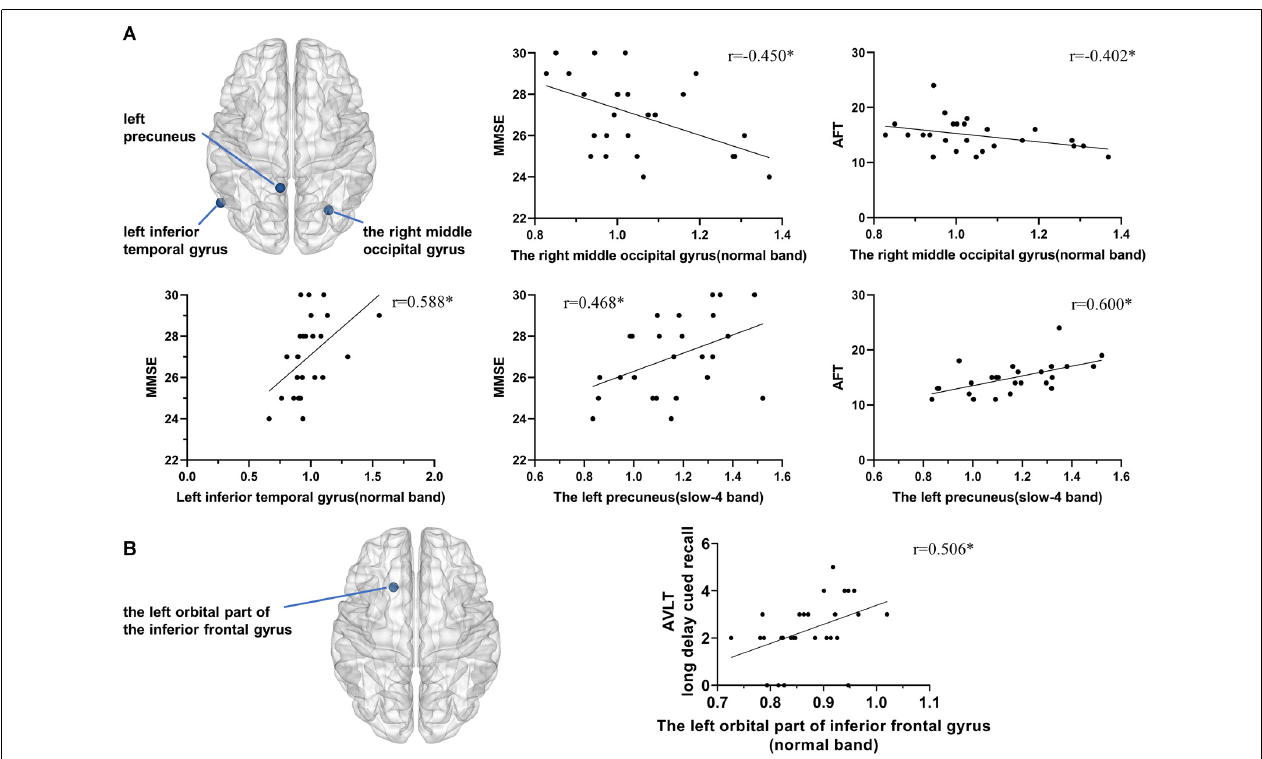
FIGURE 3 | Correlation between local functional activity and neuropsychological performance. (A) In the Obj-SCD group, in the normal band, the fALFF value of the right middle occipital gyrus was significantly negatively correlated with the MMSE score and AFT score; the left inferior temporal gyrus was significantly positively correlated with the MMSE score. In the slow-4 band, the fALFF value of the left precuneus was significantly positively correlated with the MMSE and AFT scores. (B) In the aMCI group, the fALFF value of the left orbital part of the inferior frontal gyrus was significantly positively correlated with AVLT 6th recall score. ∗ p < 0.05. Abbreviations: AFT, Animal Verbal Fluency Test; AVLT, Auditory Verbal Learning Test; MMSE, Mini-Mental State